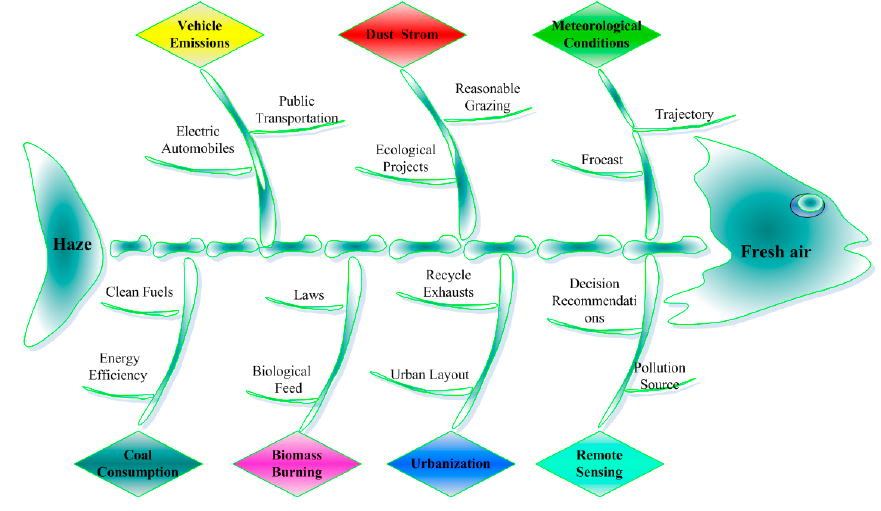
Figure 10. The mind map for decision-makers.